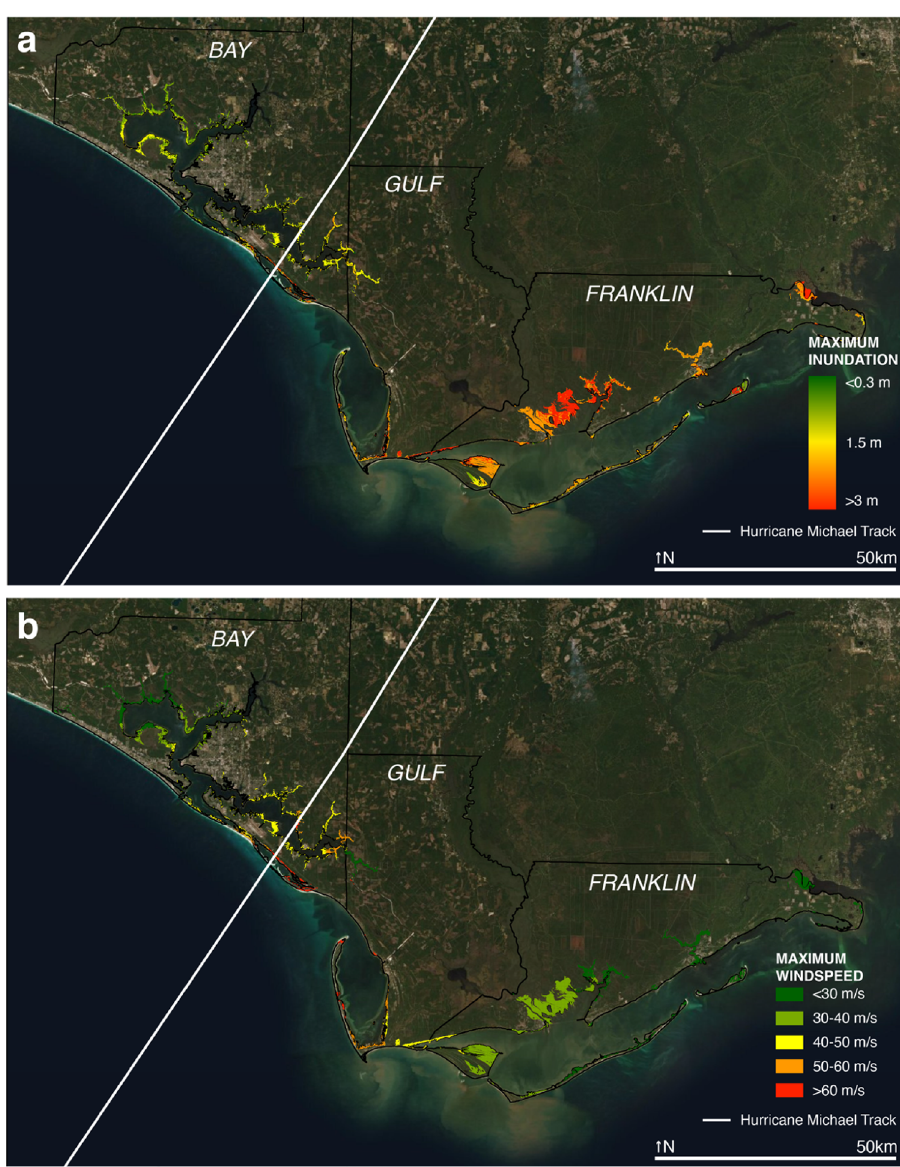
Figure 1. Hurricane Michael storm conditions and damage types. Aerial imagery for marshes in Bay, Gulf, and Franklin counties in the Florida Panhandle. Maps show ( a ) maximum inundation values, ( b ) maximum wind speed values. The track of Hurricane Michael is indicated by the white line. Map created with ESRI ArcGIS 10.8.0. Basemap sources: ESRI, Maxar, GeoEye, Earthstar Geographic, CNES/Airbus DS, USGS, AeroGrid,